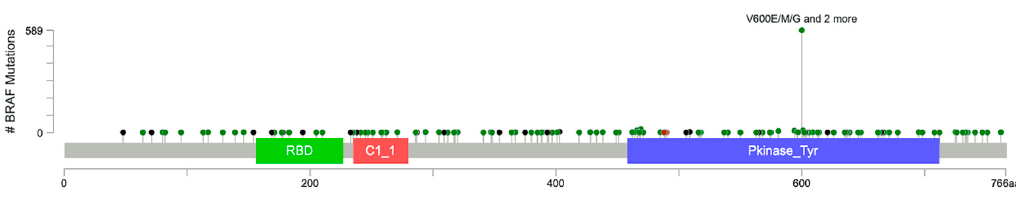
Figure 1. Pan-cancer BRAF alterations from The Cancer Genome Atlas (TCGA). TCGA-generated pan-cancer alteration frequency of BRAF was extracted from cBioportal (https://www.cbioportal.org). Data are represented as a stacked histogram plot. Colors represent different types of alterations as indicated in the legend.